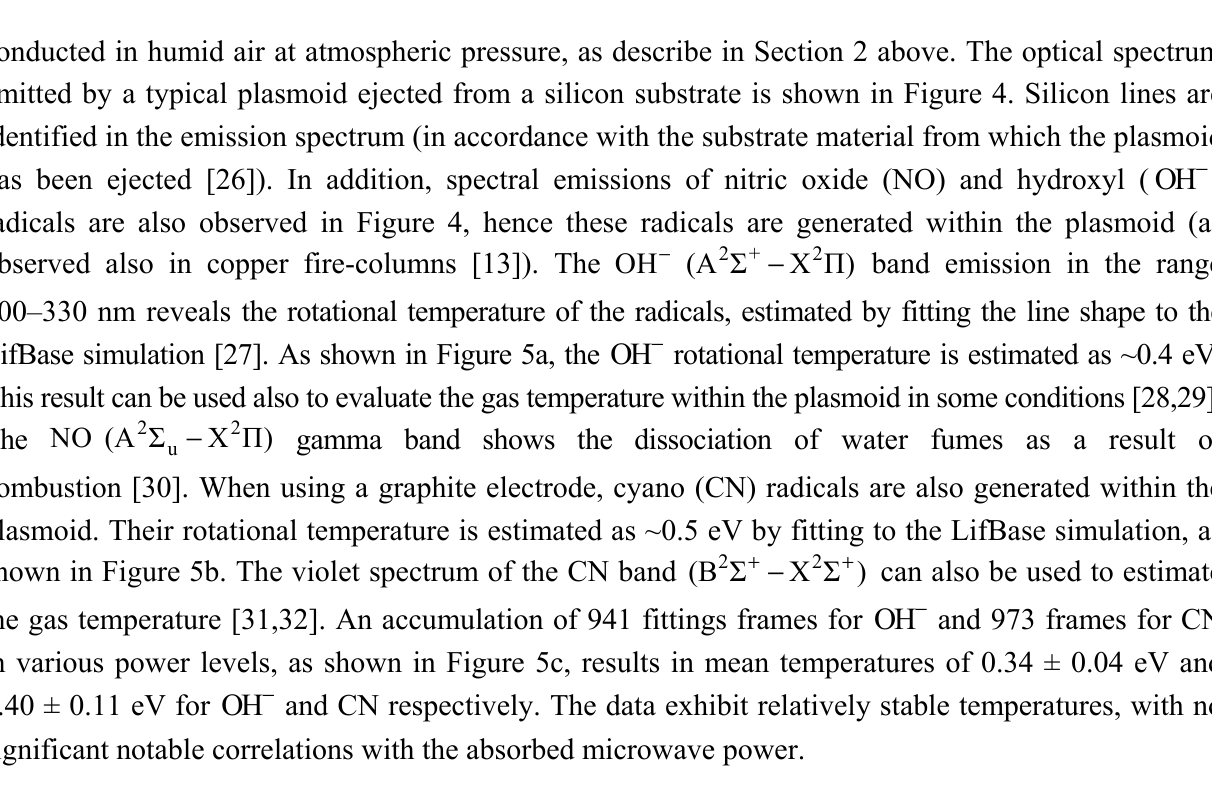
Figure 4. Optical spectroscopy measurements. A typical spectrum of silicon plasmoid reveals silicon excited atoms, and hydroxyl and nitric oxide radical